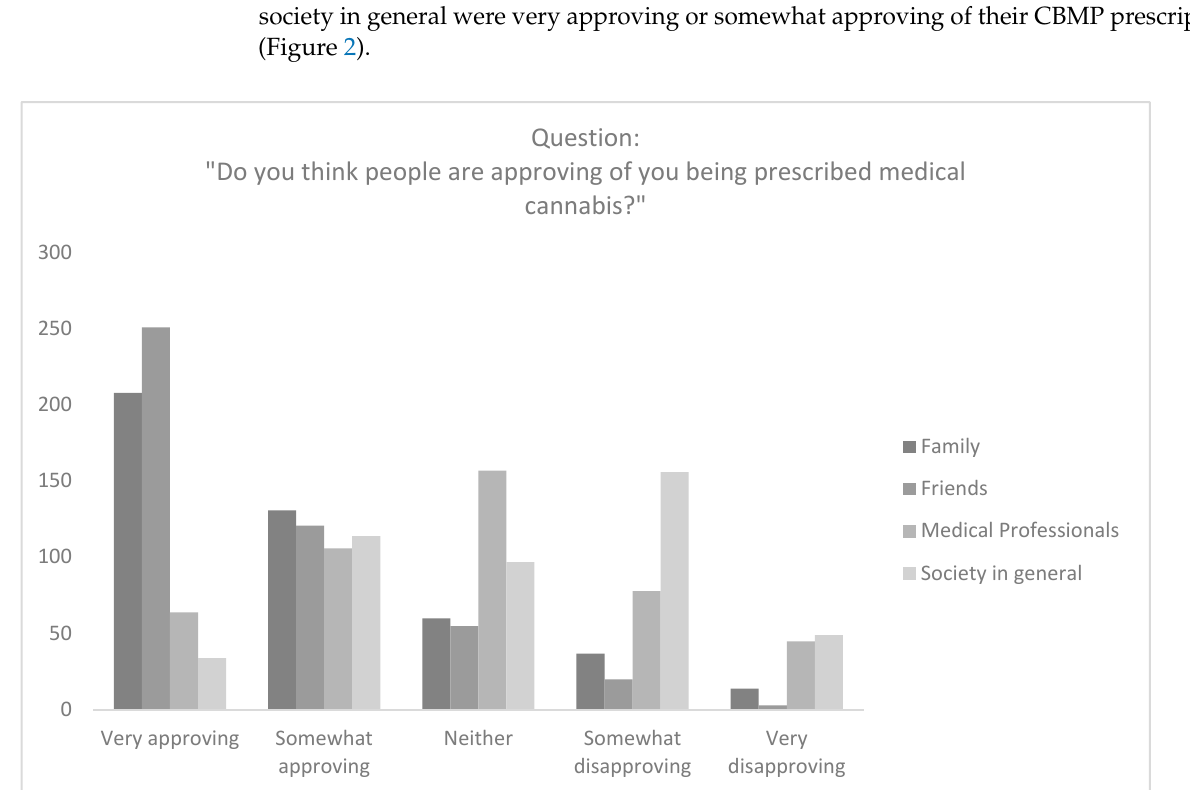
Figure 1. Raw responses to the question “Do you feel comfortable telling people you are prescribed cannabis?”.